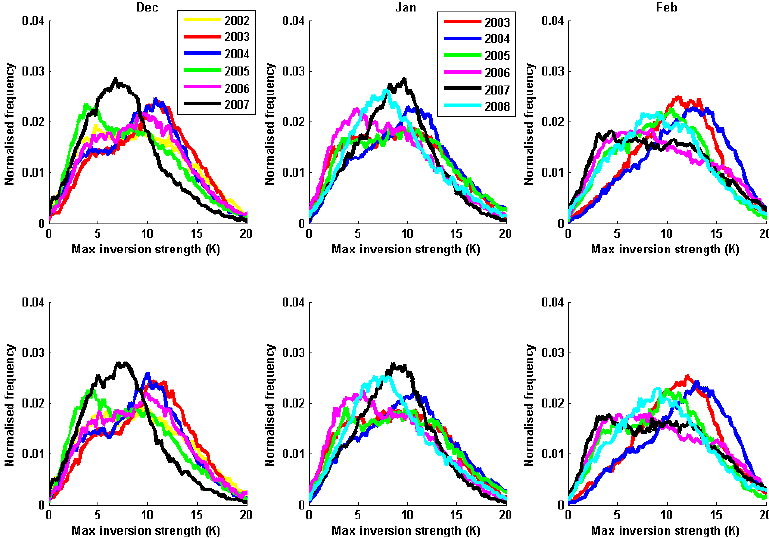
Fig. 4. Same as in Fig. 3, but for the winter